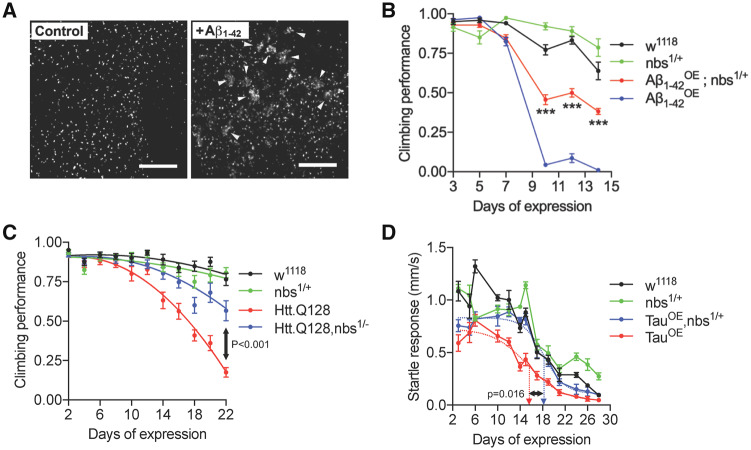

Targeting the MRN complex is neuroprotective in Drosophila models of neurodegeneration. (A) Expression of tAβ1-42 in adult neurons generates DNA double-strand breaks. Projections of central brain neurons stained with anti-pH2Av. Control neurons display a single pH2Av+ focus per nucleus corresponding to the nucleolus organising region. Multiple neurons expressing Aβ1-42 display large numbers of clustered foci (arrowheads). (B) Flies were startled by tapping to the base of a vial and the negative geotaxis climbing response quantified as a measure of neural output. Flies expressing (B) Aβ1-42 or (C) Htt.Q128 in adult neurons show a rapid decline in climbing ability which is partially suppressed in flies heterozygous for a null allele of nbs. Statistical comparisons in B by two-way ANOVA and in B by extra sum-of-squares F-test, *** indicates P < 0.001. (D) When stimulated by vibration, Tau-expressing flies show a rapid decline in the startle response which is partially suppressed in nbs1/+flies. Dashed arrows indicate days of expression required for 50% decline in response determined from fitted lines; comparison by two-tailed t-test. Scale bars in A = 10 µm.